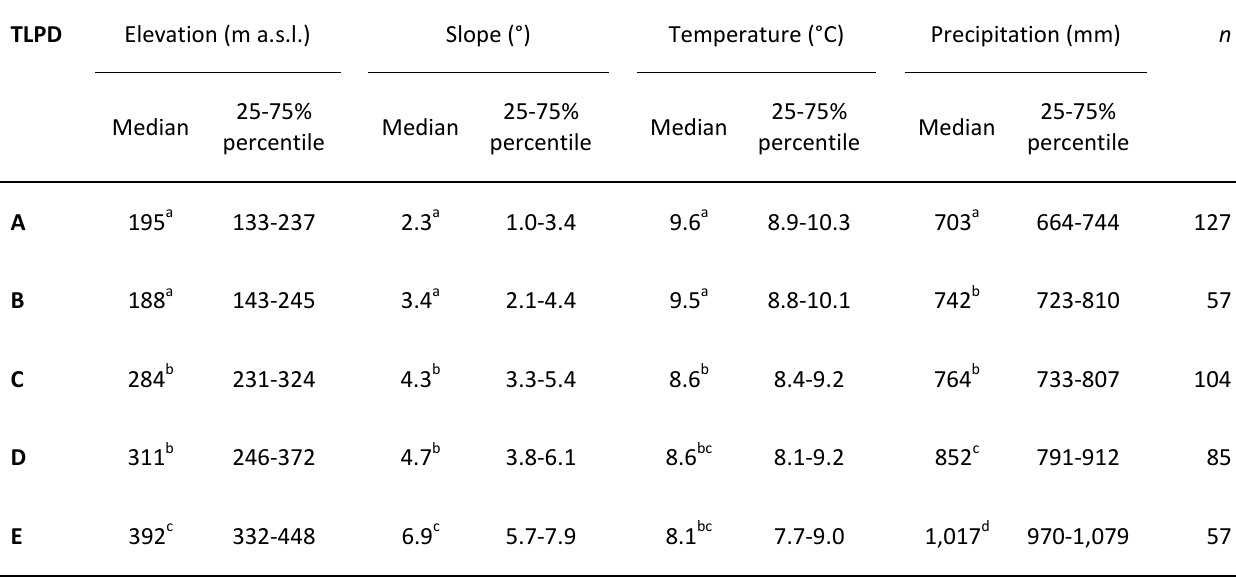
TLPD Elevation (m